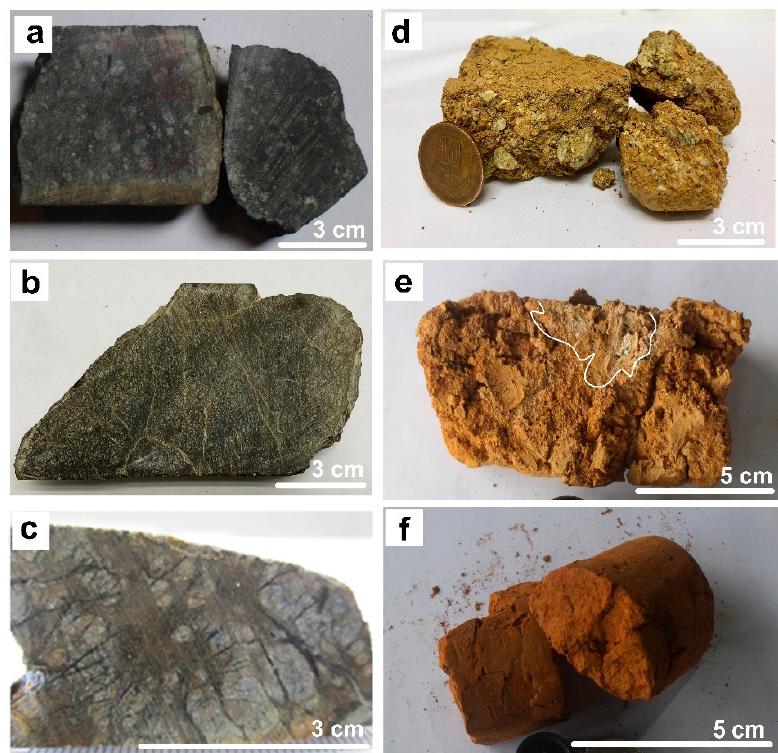
Figure 3. Photos of ( a ) serpentinized lherzolite (BB2515 core), ( b ) harzburgite-dunite (BB2406 core), and ( c ) clinopyroxenite (PG1500 core), ( d ) earthy material including pebble-sized rock remnants ( e ) silica-bearing limonite sample from the limonite horizon, and ( f ) dark orange highly weathered materials.